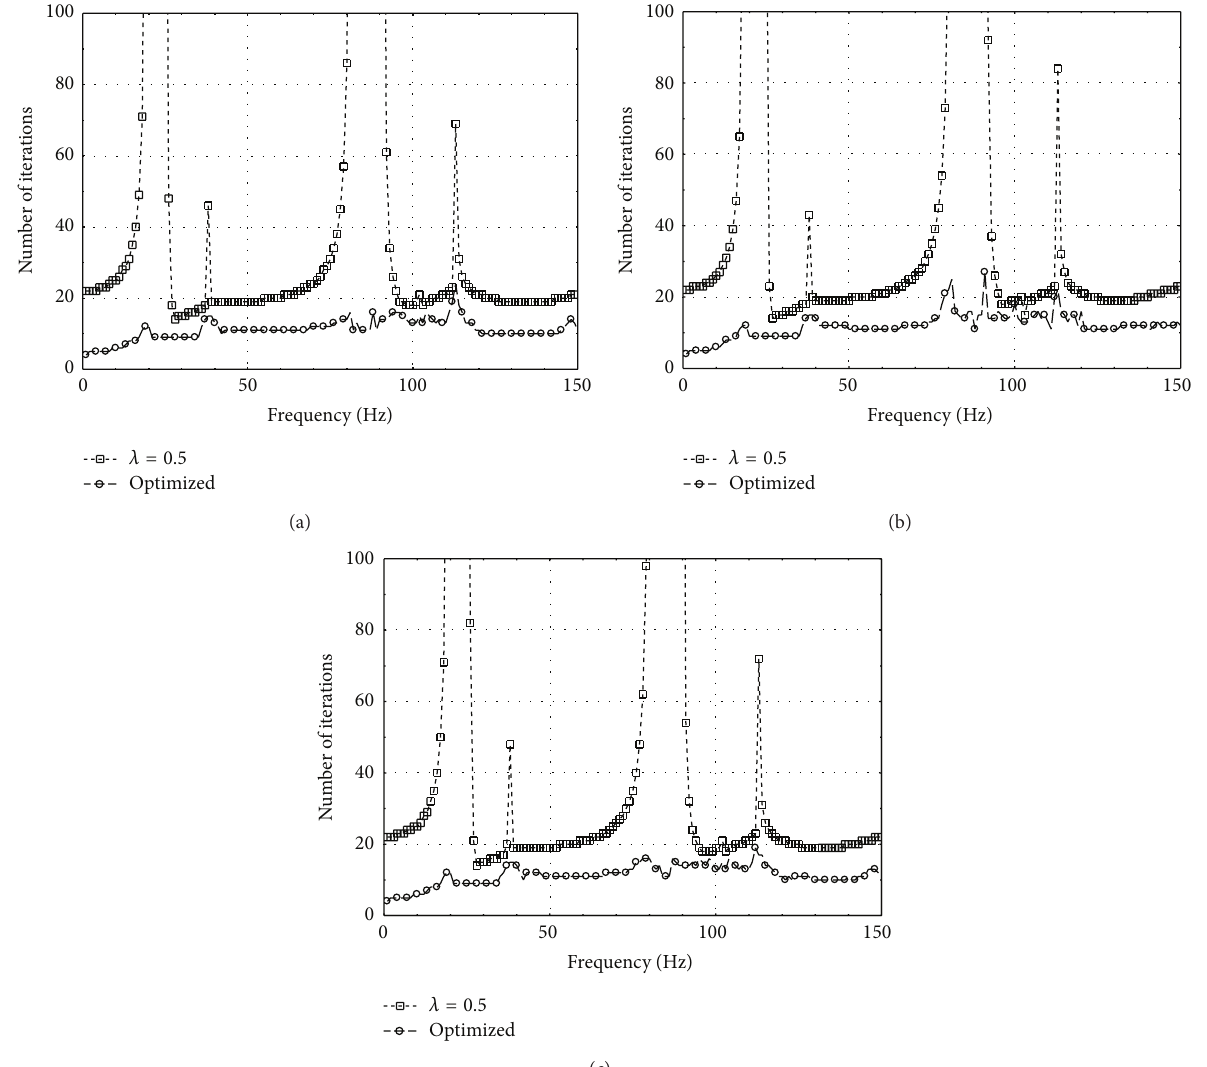
Figure 17: Number of iterations required for convergence: (a) MFS-FEM; (b) MFS-CM; (c) MFS-MLPG.